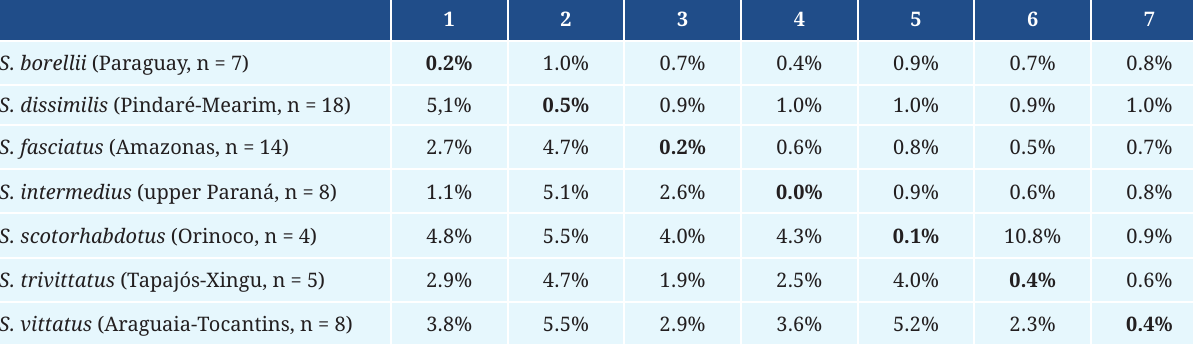
TABLE 1 | Pairwise K2P genetic distances among species of the Amazonas clade of Schizodon based on COI sequences (603 base pairs). Numbers in bold (diagonal) represent the genetic distance within sample, whereas the mean genetic distances among samples are indicated below diagonal, with values of standard error above diagonal. Groups were ordered based on Maximum Likelihood analysis. The overall mean genetic distance equals 3.4%